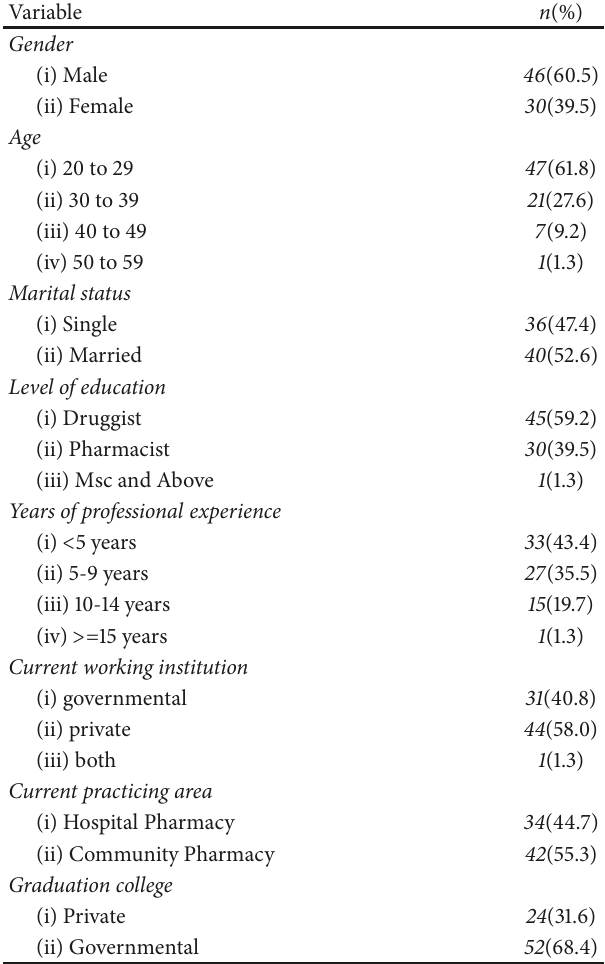
Table 1: Sociodemographic characteristics of the